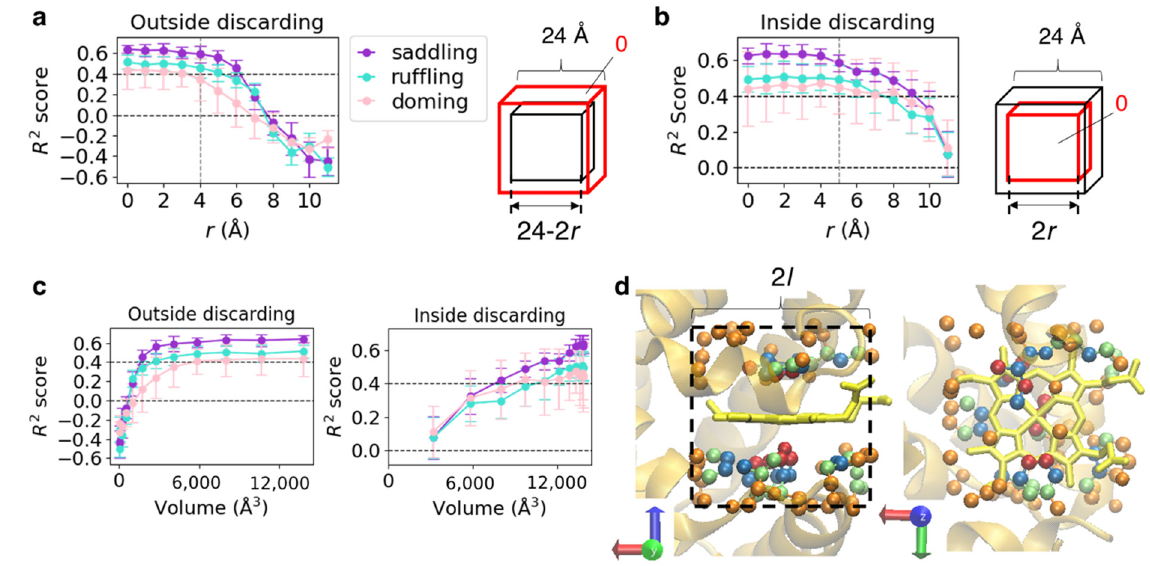
Figure 4. ( a ) Mean R 2 scores for each vibrational mode versus r , which represents the distance between the faces of the red and black cubes illustrated in the right panel. The error bar shows standard deviation. The red and black cubes have an identical center, and their edges are parallel. The red cube is equivalent to the inclusion region used as the CNN input. Voxel values in the region between the red and black cubes were replaced by 0. ( b ) Mean R 2 scores for each vibrational mode versus r . Voxel values in the red cube were replaced by 0. The coloring method is the same as that in ( a ). ( c ) R 2 scores identical to those in ( a , b ) versus the volume of the region including the original information. The coloring method is the same as that in ( a ). ( d ) Atoms included in cube-shaped regions with the edge length of 2 l are illustrated using PDB ID 1mba as an example. The dark red, lime, marine-blue, and orange spheres represent l = 4, 5, 6, and 7, respectively. The backbone of the host protein is represented as an orange cartoon and heme as a yellow licorice